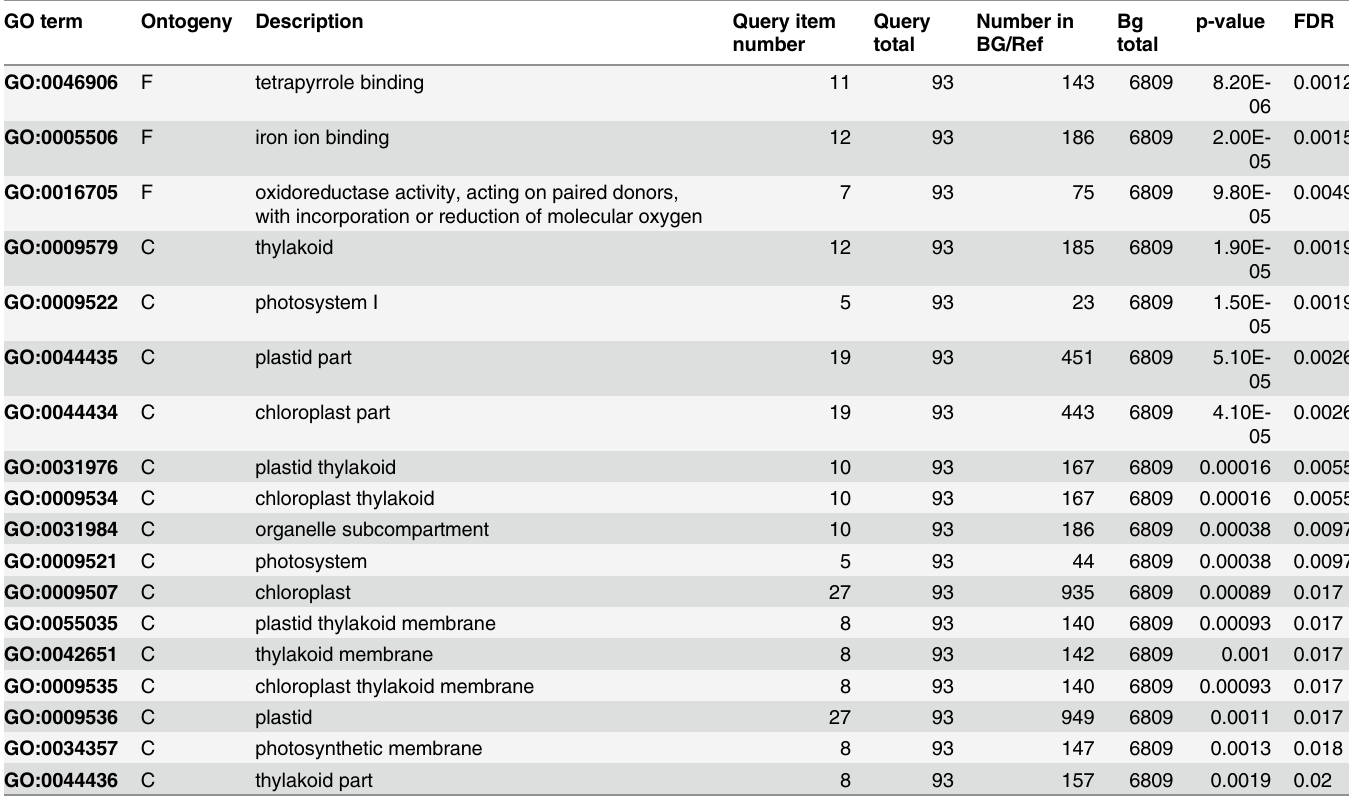
Table 1. The overrepresented functional GO terms of the genes specifically or preferentially in the selfed ovules of Xanthoceras sorbifolium